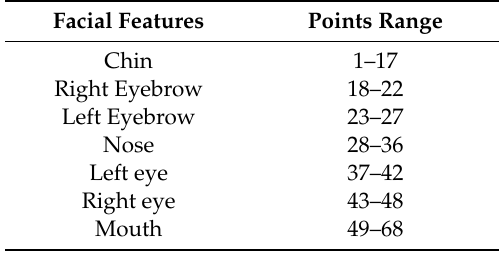
Figure 11. Template image for face’s landmark detection using 68-points for a frontal view. Table 1. The points range for each face feature in 68-points face’s landmarks. Facial Features